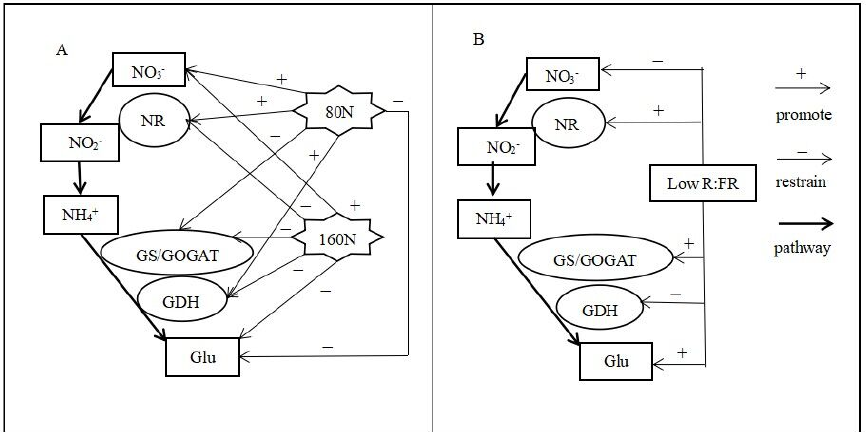
Figure 5. Pattern of nitrogen assimilation in pakchoi with different nitrogen levels regulated by a low R:FR. H80 represents the extra addition of 80 mmol · L − 1 NO 3 − nitrogen treatment, and H160 represents the extra addition of 160 mmol · L − 1 NO 3 − nitrogen treatment. ( A ) represents the effect of nitrogen treatment on the nitrogen metabolism pathway, and ( B ) represents the effect of reducing the red:far-red (R:FR) ratio on the nitrogen metabolism pathway.